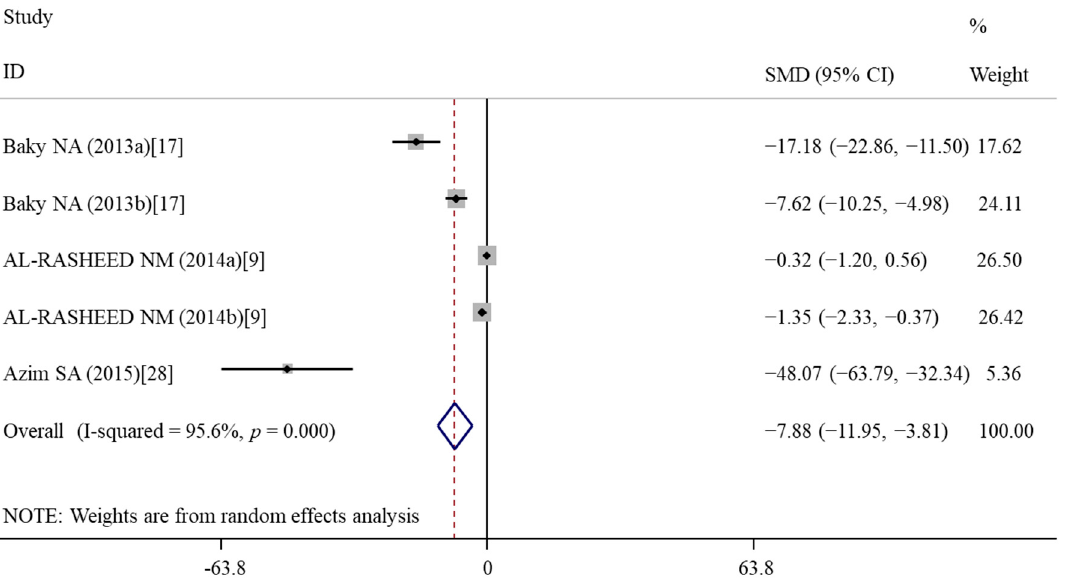
Figure 9. Forest plots showing the protective effects of vitamin E on tail length of murine models compared with the nanomaterial exposure group. a, b of the study of Baky et al. and AL-RASHEED et al. represent treatment with 600 and 1000 mg/kg of ZnONPs. SMD, standardized mean difference; CI, confidence interval. [9,17,28]